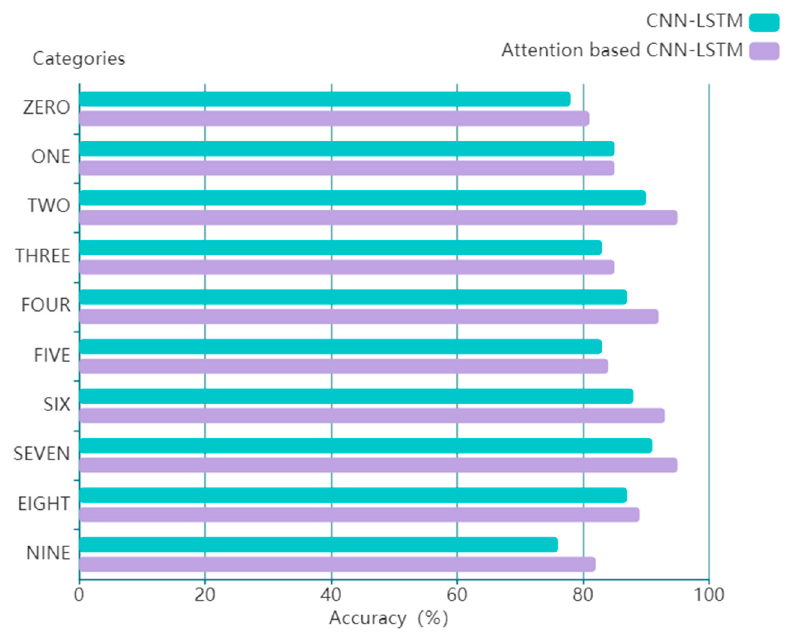
Figure 10. Comparisons of recognition accuracy between two networks.